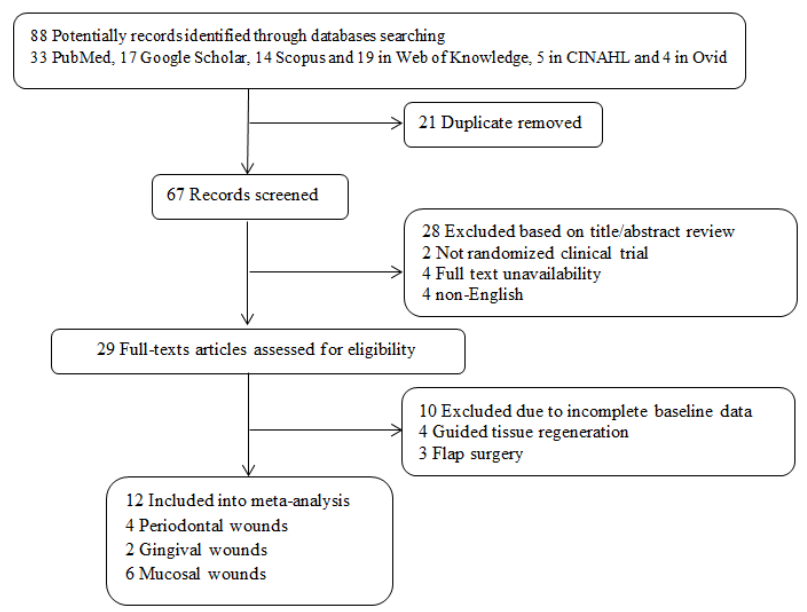
Figure 1 . The flowchart of screening the eligible studies. CINAHL: Cumulative Index of Nursing and Allied